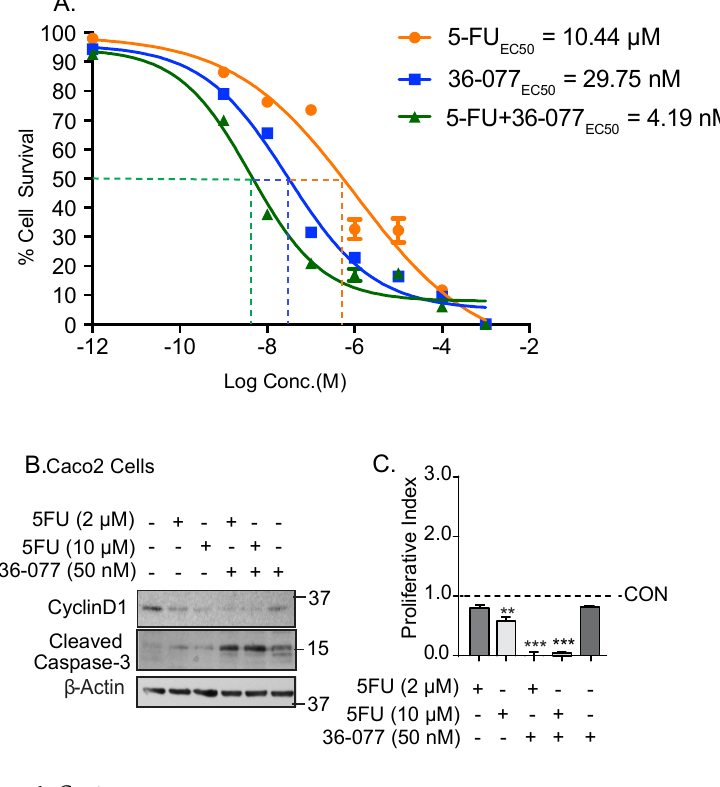
Figure 4. Combination treatment of 36-077 and 5-FU synergizes to inhibit colon cancer cell sur- vival. Caco-2 and HCT116 cells were treated with 5-FU with or without 36-077 for 24 h. ( A ) Cell death was analyzed using cell viability assay. Effects of 5-FU and 36-077 alone, and in combination (HCT116 cells); ( B – G ) immunoblotting using total cell lysates from control and treated cells, and densitometry analysis. Caco-2 and HCT116 cells and colon tumoroids were used. Proliferative